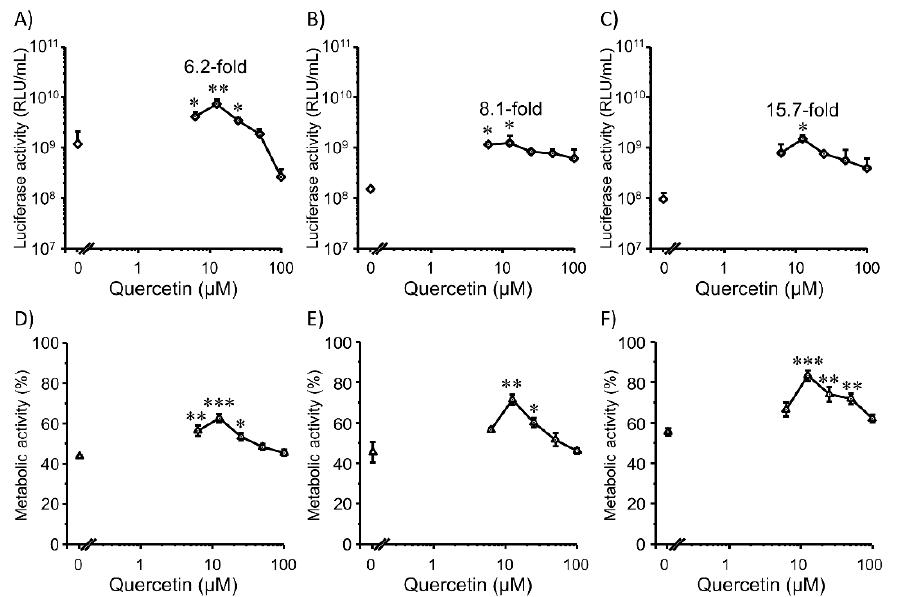
Figure 5. Effects of co-incubation with quercetin (0–100 µ M) at three different transfection timings after seeding cells for 4 h ( A , D ), 3 d ( B , E ), and 7 d ( C , F ) on transfection efficiency ( A – C ) and metabolic activity ( D – F ) mediated by Lipofectamine 3000/plasmid DNA (pcDNA3/GL 0.2 µ g/well) complexes in 3D Colon26 cells. Each dot represents the mean ± SD ( n = 3). * p < 0.05, ** p < 0.01, *** p < 0.001 compared with the control (0 µ M quercetin).